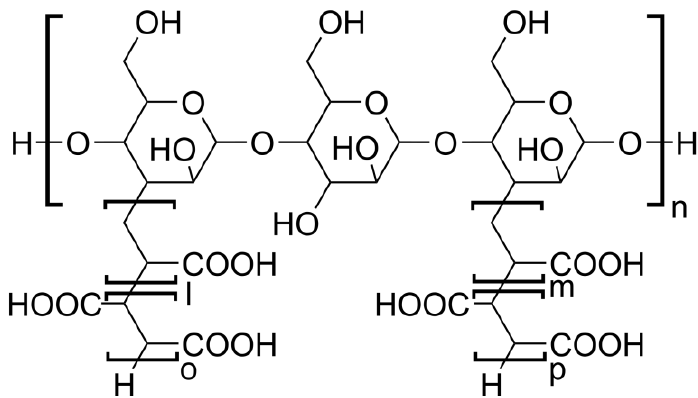
Figure 1. Possible structure of the poly(acrylic acid) chains with maltodextrin (PAA-MD) hybrid graft polymer resulting from radical polymerization. Units denoted l, m, n, o and p are of unknown lengths.